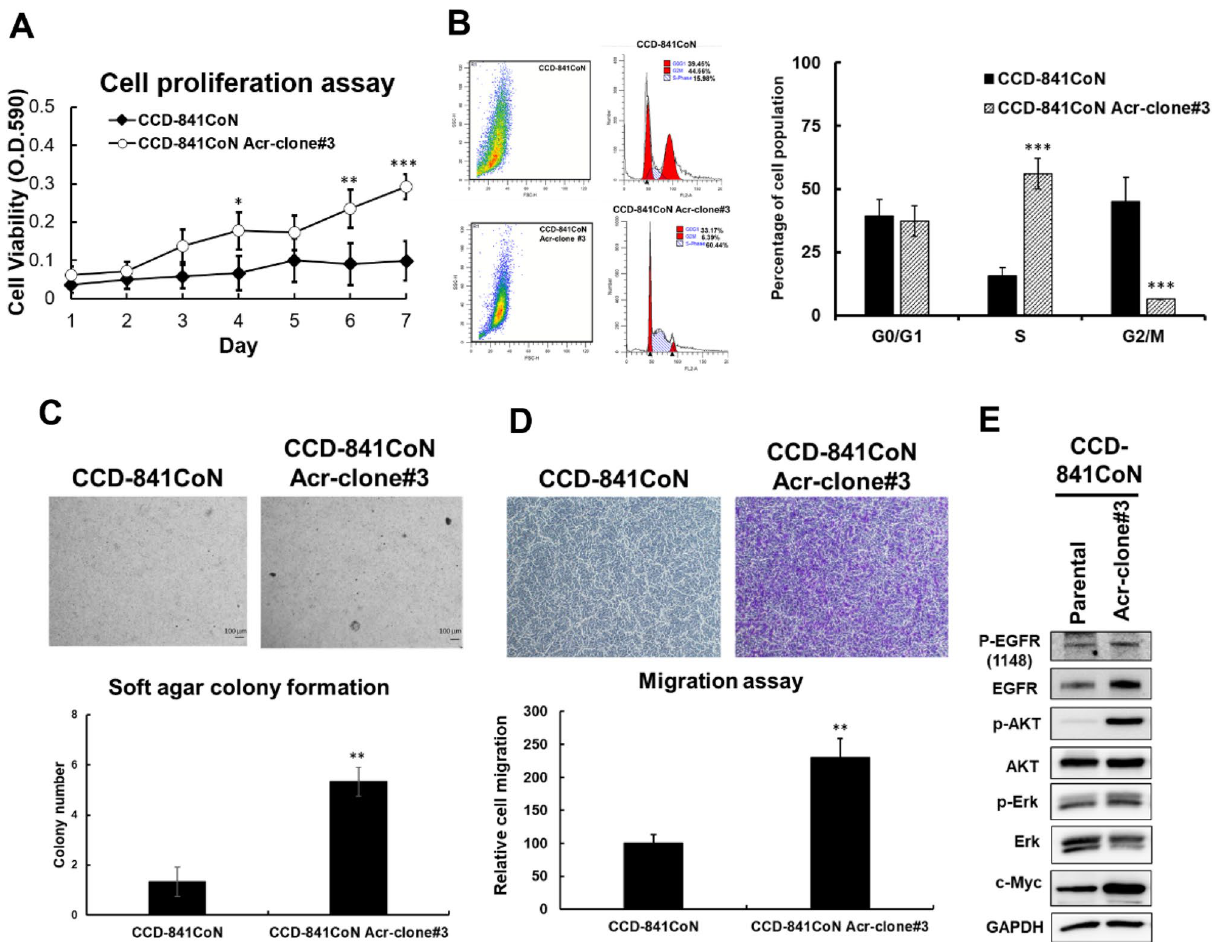
Figure 4. Acrolein induced oncogenic transformation in CCD-841CoN cells. CCD-841CoN cells were treated with acrolein (Acr, 7.5 μM) for one month and named CCD-841CoN Acr-clone#3. (A) Cell proliferation of CCD-841CoN Acr-clone#3 was analyzed using MTT assays. (B) Cell cycle progression of CCD-841CoN Acr-clone#3 was analyzed using cell cycle analysis with PI staining. (C) Soft agar anchorage-dependent cell growth of CCD-841CoN Acr-clone#3 was analyzed using a soft agar assay. Scale bar: 100 µm. (D) The cell migration activity of CCD-841CoN Acr-clone#3 cells was analyzed using Transwell migration analysis.